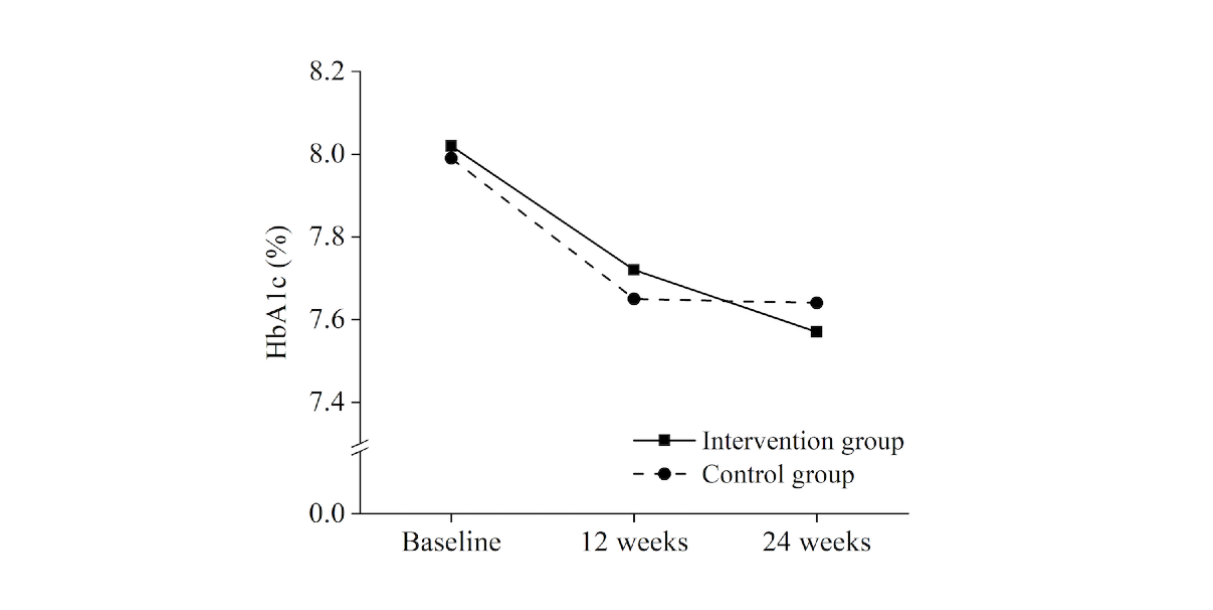
Figure 2. Mean hemoglobin A 1c (HbA 1c ) levels during the 24-week study